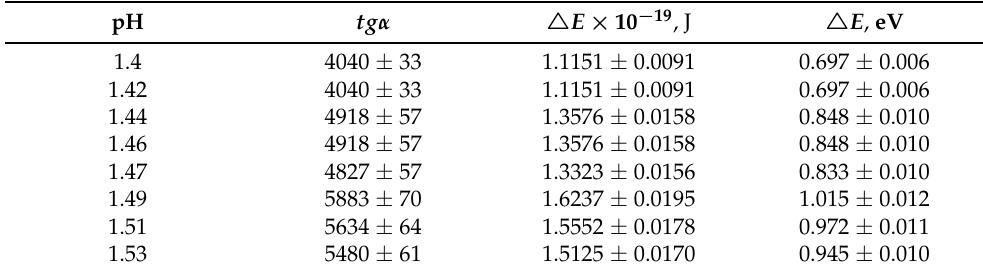
Figure 15. Natural logarithm of the conductivity versus inverse temperature. Table 3. Optical bandgap and Burstein–Moss